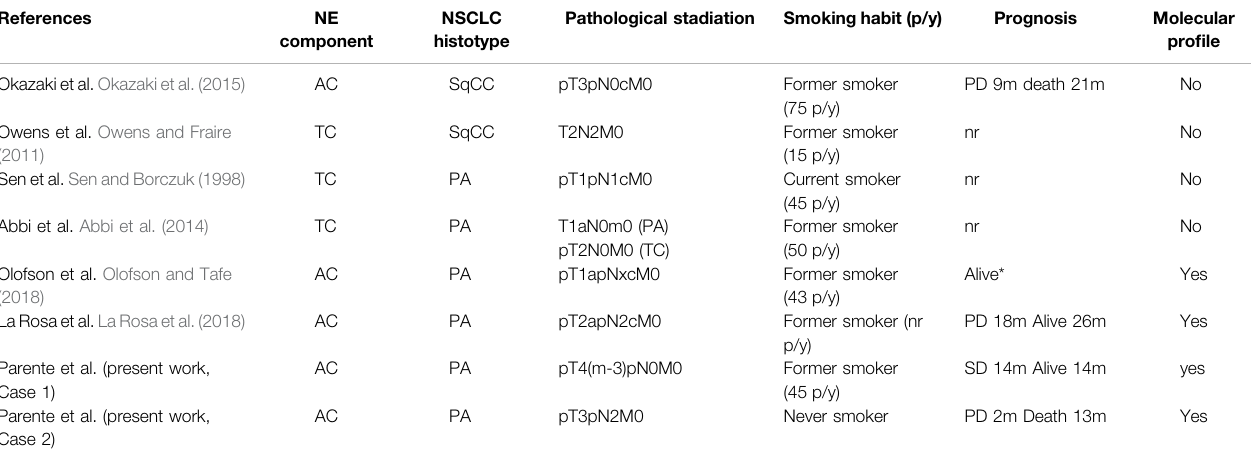
TABLE 1 | Clinical and pathological features of reported combined pulmonary